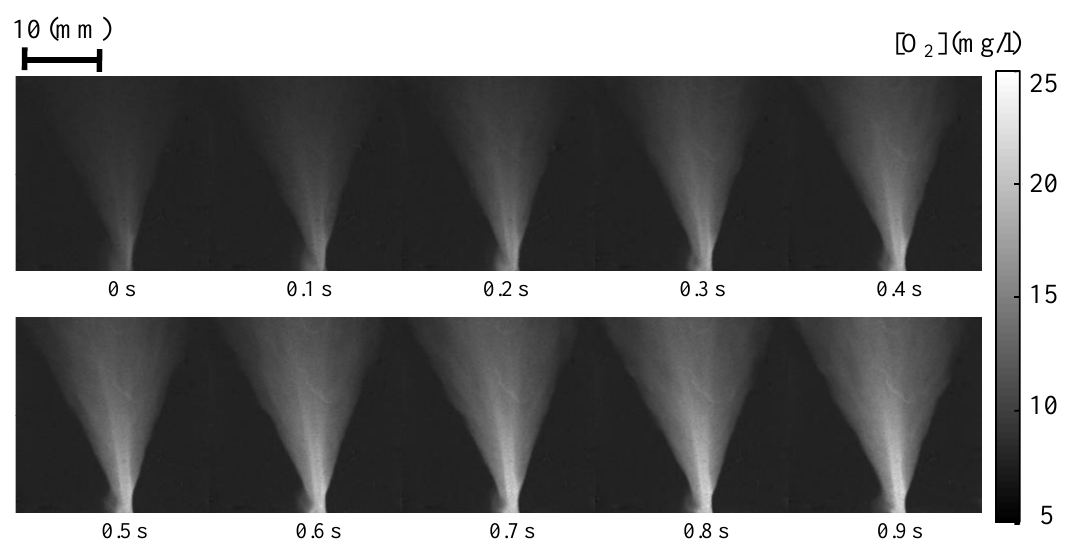
Figure 13. Global oxygen detection results. Oxygen distributions every 0.1 s are